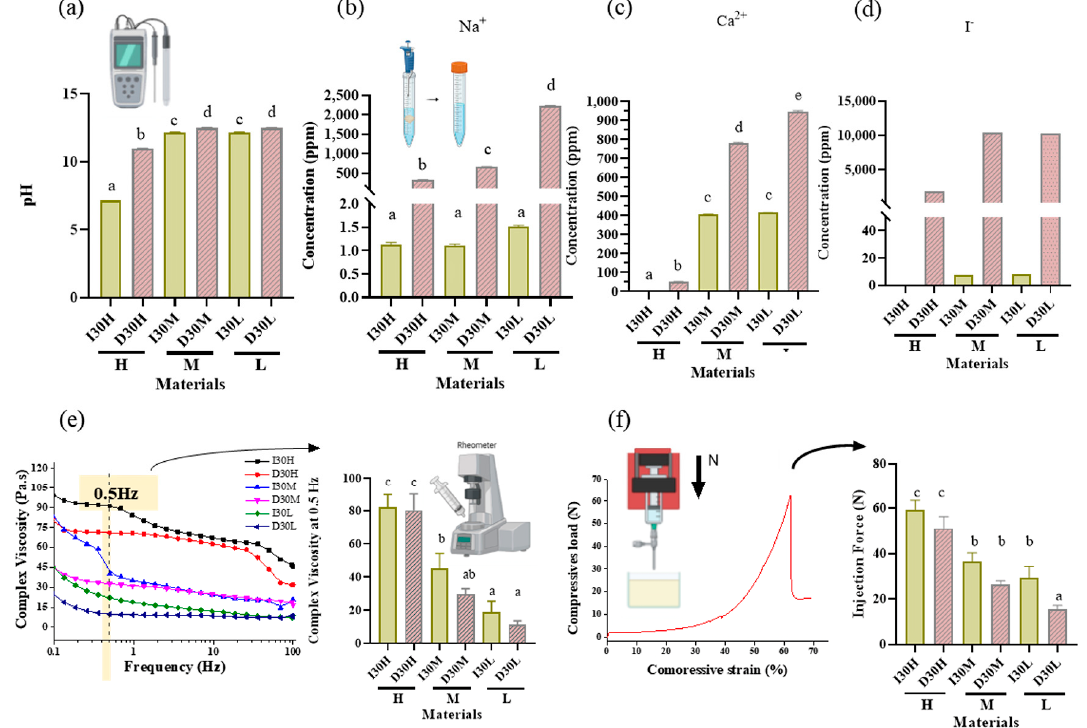
Figure 2. pH analysis and extraction analysis of iodoform-based and NaI-based paste (I30 and D30). ( a ) The pH was higher in the D30 groups than in the I30 groups. ( b , c ) Sodium and calcium ions were extracted using inductively coupled plasma atomic spectrometry (ICP/AES). The sodium and calcium concentrations were higher in the D30 group than in the I30 group. ( d ) Iodoform extracted by ion chromatography. The concentrations of iodoform were higher in the D30 group than in the I30 group. ( e ) Overall viscosity in the linear graph and viscosity at 0.5 Hz is shown in the bar graph. The viscosity of the I30 group was higher than that of the D30 group. Silicone oil with the L group showed the lowest viscosity compared to H and M silicone oil groups. ( f ) The highest compressive load is the site when the material extrudes out of the syringe. This peak load is shown in the bar graph. The injection force of the D30 group was lower than the I30 group. Silicone oil with the L group showed the lowest injection force compared to H and M silicone oil groups. Di ff erent superscript le tt ers mean statistically signi fi cant di ff erences among groups. Error bars mean standard deviations ( p < 0.05).